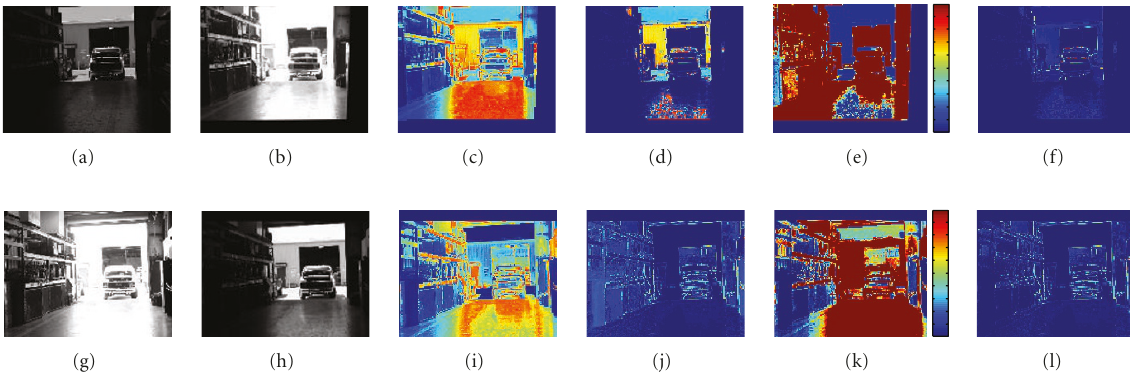
Figure 6: Weighting function e ff ect on residuals. First row performs conversion onto low-exposure reference while second row has a ref- erence with high exposure: (a) reference image; (b) geometrically warped input image; (c) residual image without tonal conversion; (d) residual image using nonlinear tonal conversion; (e) certainty image using hat function as weighting and image (b) as input; (f) weighted residual obtained multiplying residual image in (d) by certainty image in (e); (g) reference image; (h) geometrically warped input image; (i) residual image without tonal conversion; (j) residual image using nonlinear tonal conversion; (k) certainty image using hat function as weighting and image (g) as input; (l) weighted residual obtained multiplying residual image in (j) by certainty image in (k).